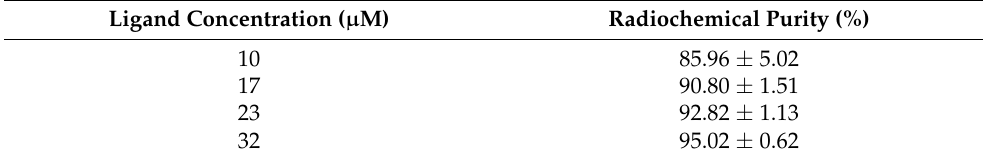
Table 1. Radiolabeling efficiency using different ligand concentration for 15 min at 95 ◦ C ( n = 3). Ligand Concentration ( µ